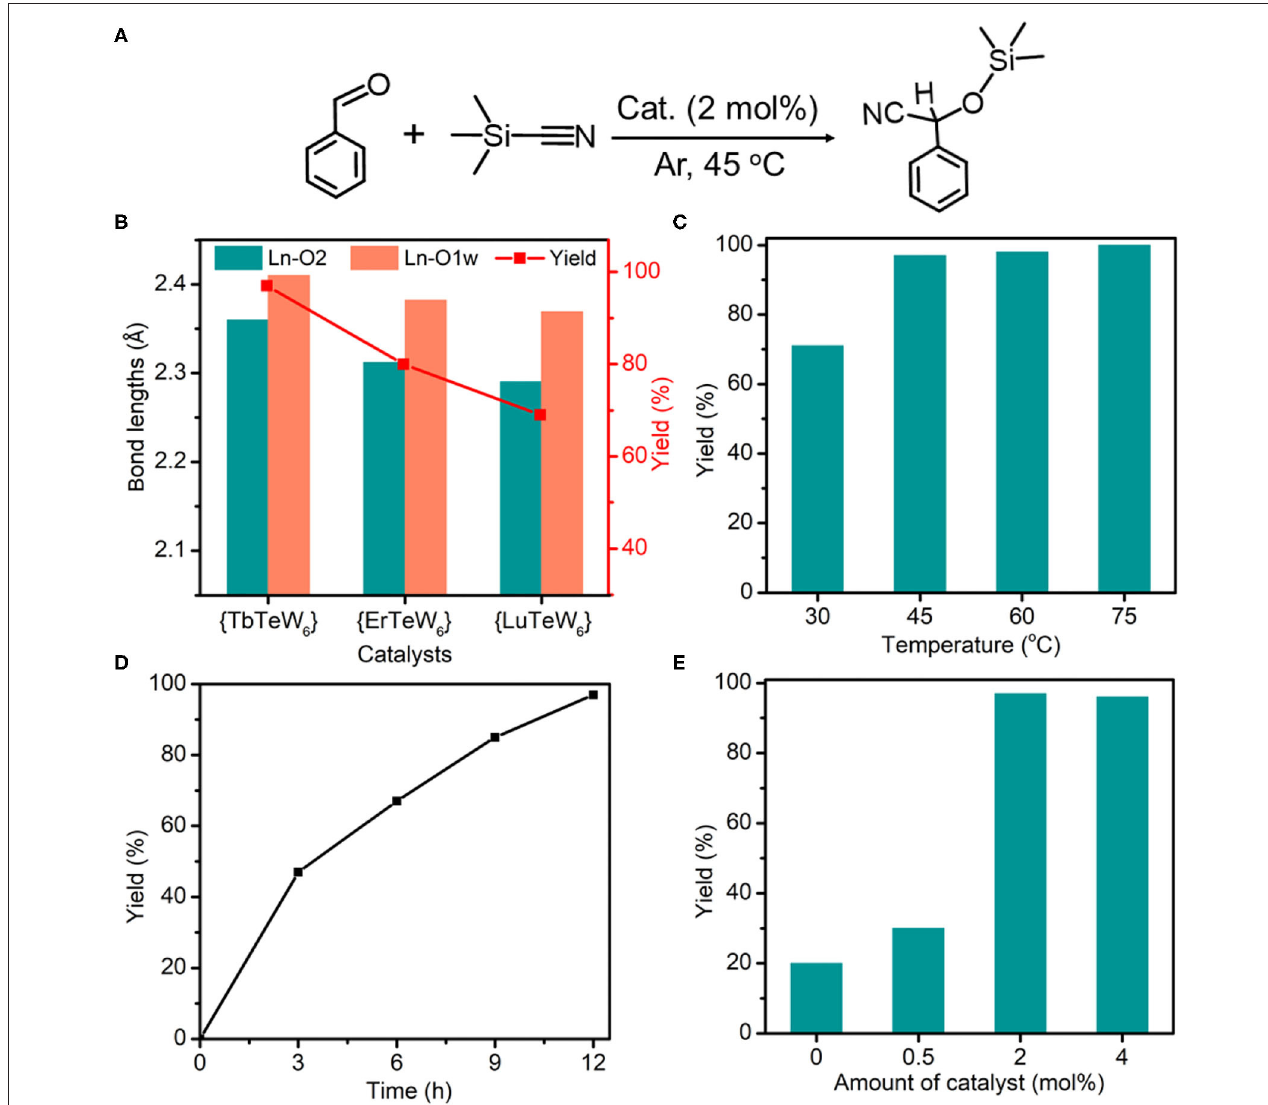
FIGURE 3 | (A) The cyanosilylation reaction of benzaldehyde with trimethylsilylcyanide (TMSCN). (B) The Ln–O 2 bond lengths and the yield of cyanosilylation catalyzed by {TbTeW 6 }, {ErTeW 6 }, and {LuTeW 6 }, respectively. (C) Effect of temperature on cyanosilylation using {TbTeW 6 }. (D) Time profile for cyanosilylation catalyzed by {TbTeW 6 }. (E) Effect of the amounts of {TbTeW 6 } on cyanosilylation. Reaction conditions: benzaldehyde (1 mmol), TMSCN (2 mmol), {TbTeW 6 } (2 mol%, relative to the benzaldehyde), naphthalene (0.75 mmol, internal standard) under Ar atmosphere, 45 ◦ C, 12h.